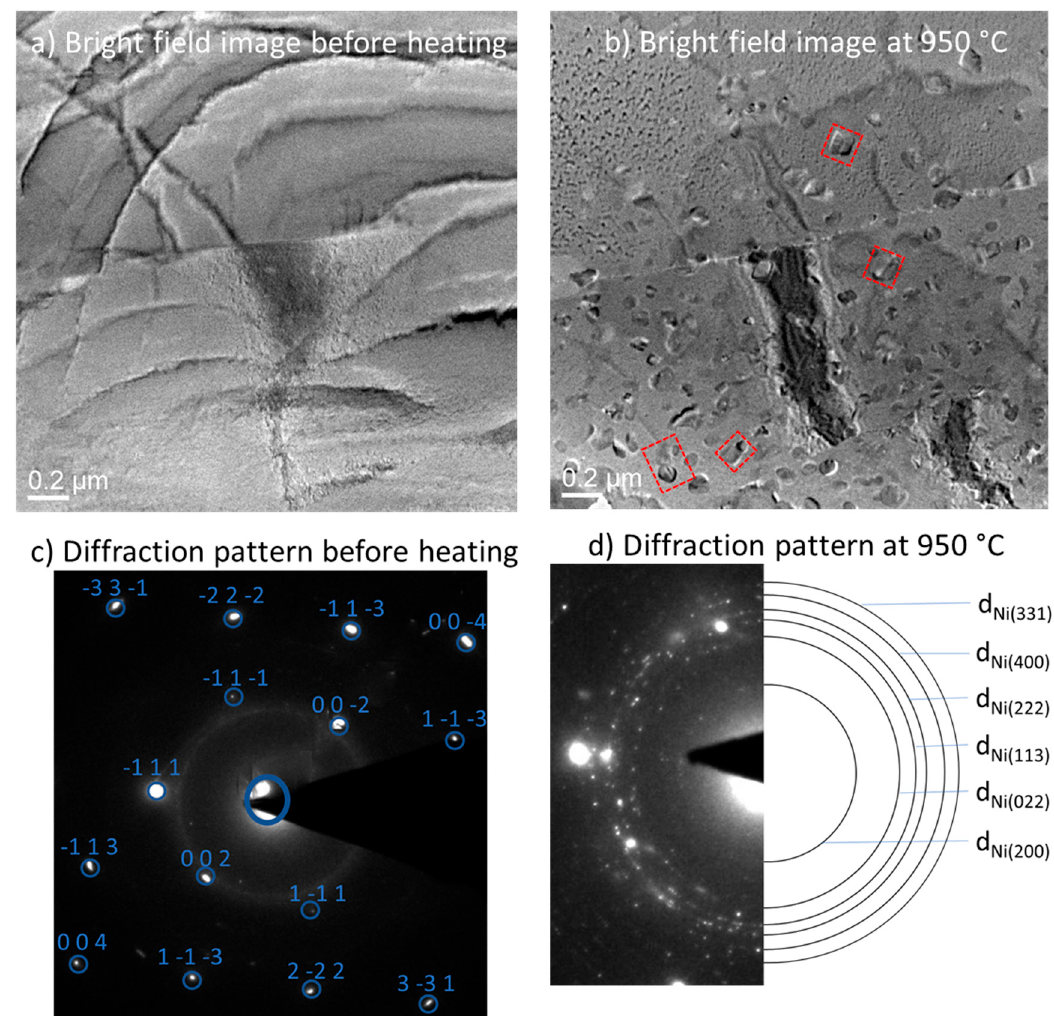
Figure 3. ( a ) Bright field TEM image after first heat-treatment step and before the start of in-situ heating, ( b ) bright field TEM image when the temperature of the sample has reached 950 °C, ( c ) diffraction pattern before the start of in-situ heating, and ( d ) diffraction pattern when the sample has reached 950 °C.